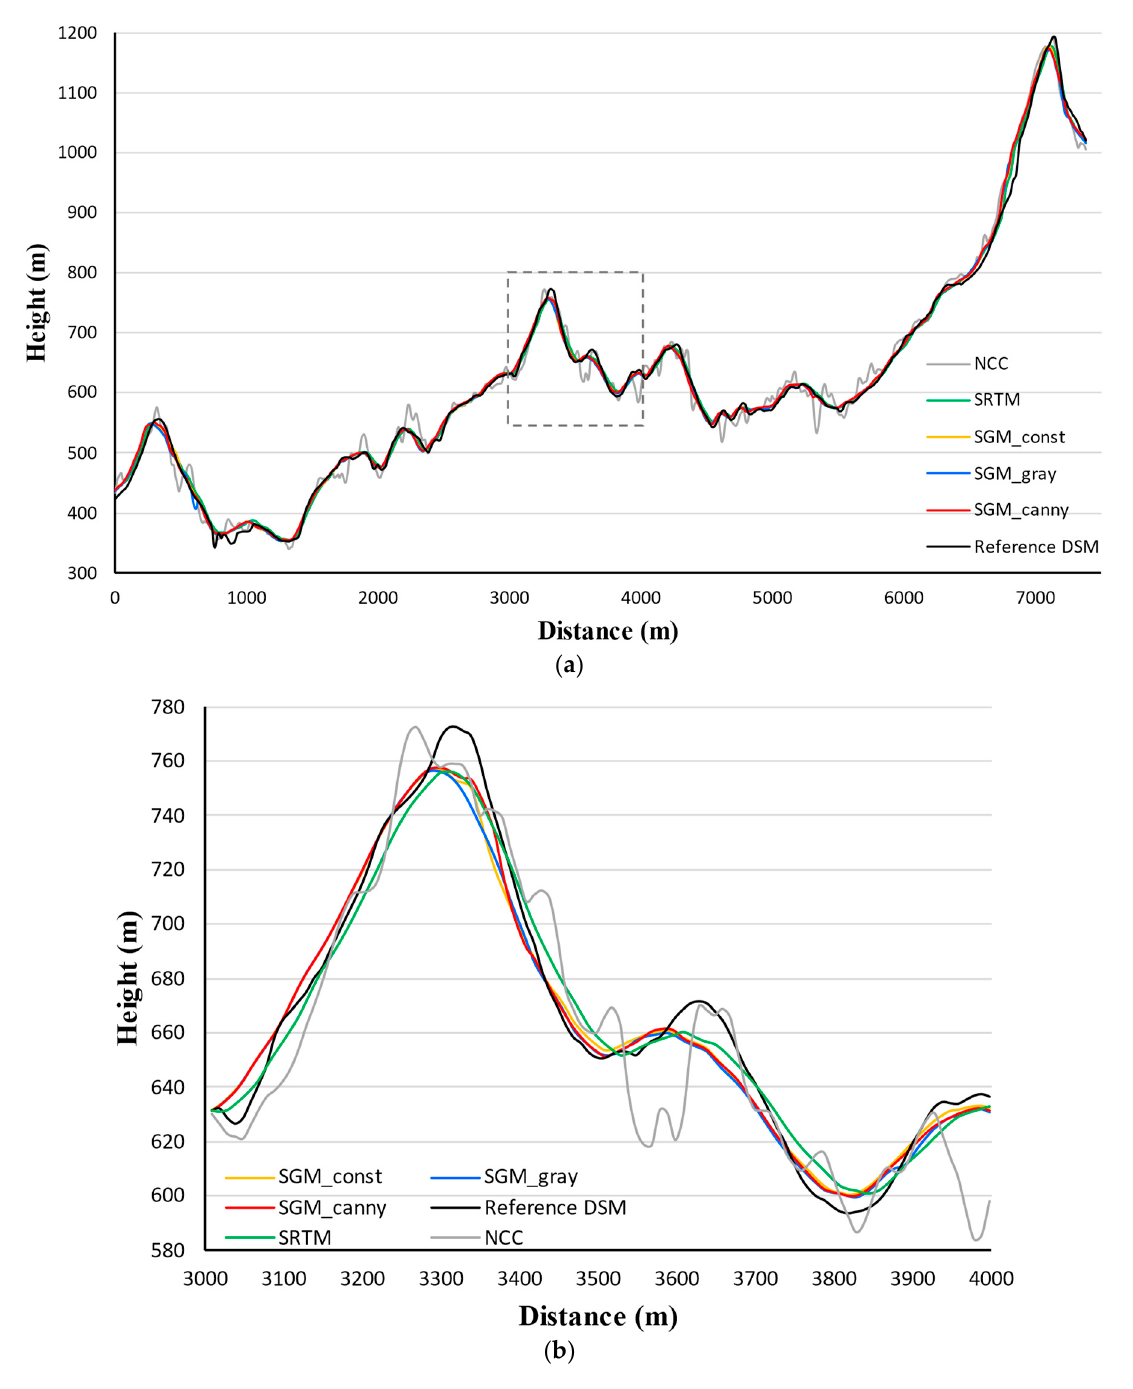
Figure 7. ( a ) DSM profiles along the line segment “n” in Figure 5c; ( b ) Zoomed view of profiles corresponding to the dotted box in Figure 7a.